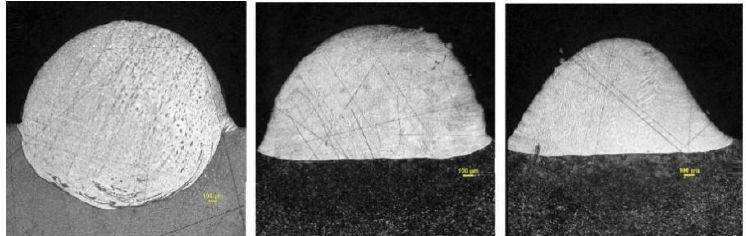
Figure 7. Cross sections of the consolidated material made with a layer of 1 mm of powder with 4000 W, 400 mm/s ( left ), 600 mm/s ( center ) and 800 mm/s ( right ).